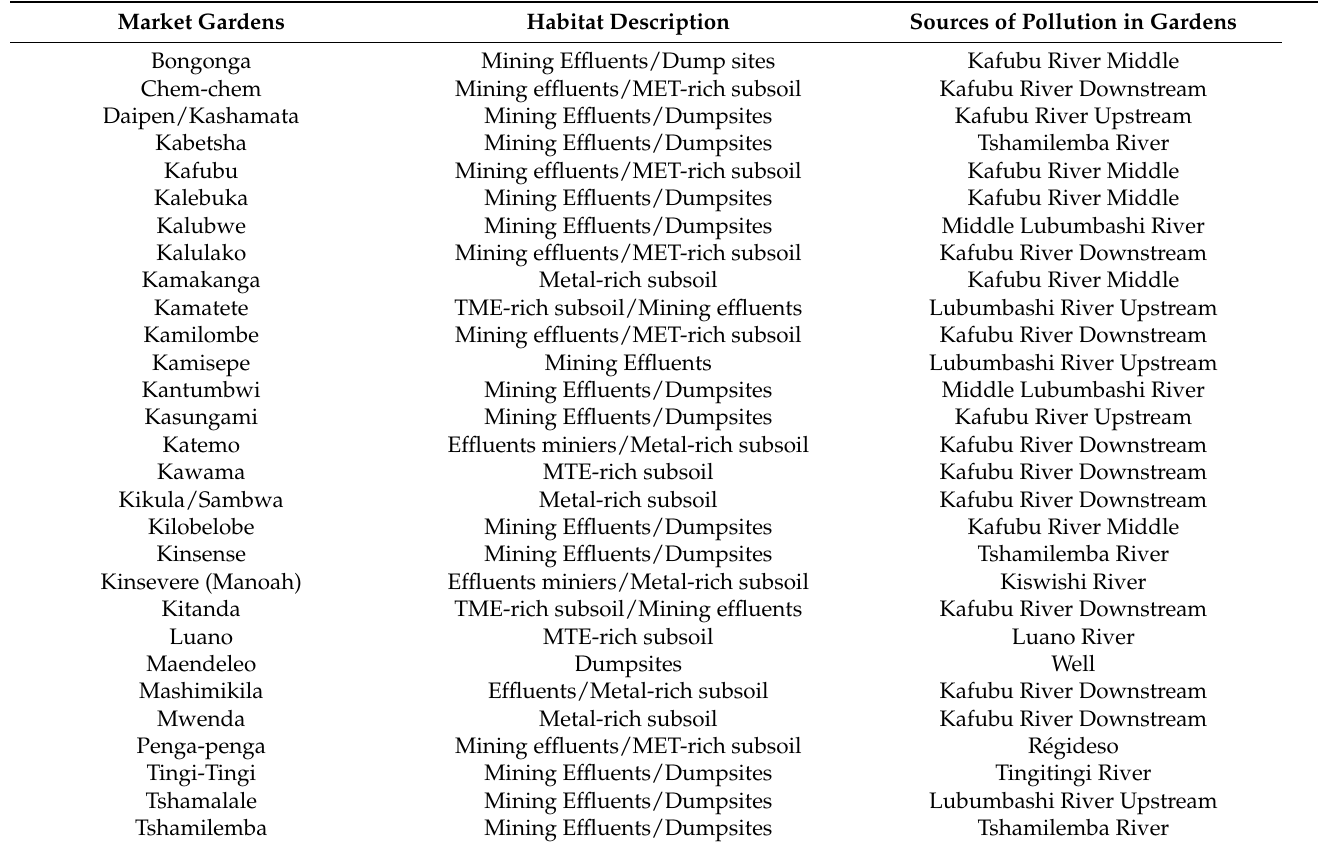
Table 1. Description of the ecosystem at study locations near pollution